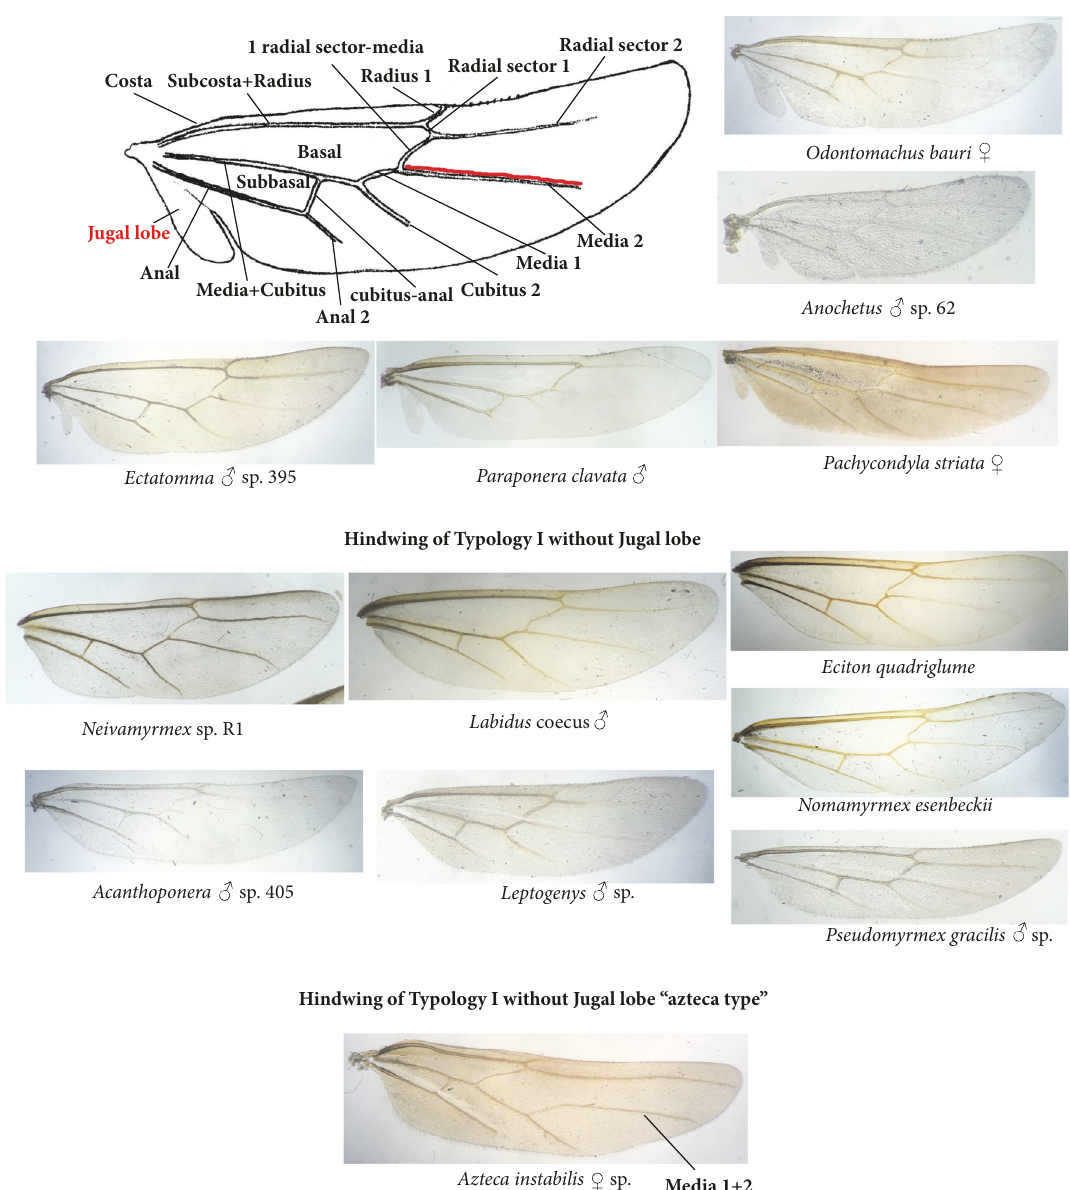
Figure 1: Hindwing of Typology I with Cells and Veins terminology. The photos represent some examples of hindwings of Typology I; the dimensions are not comparable (photos by personal Cantone collection of Winged